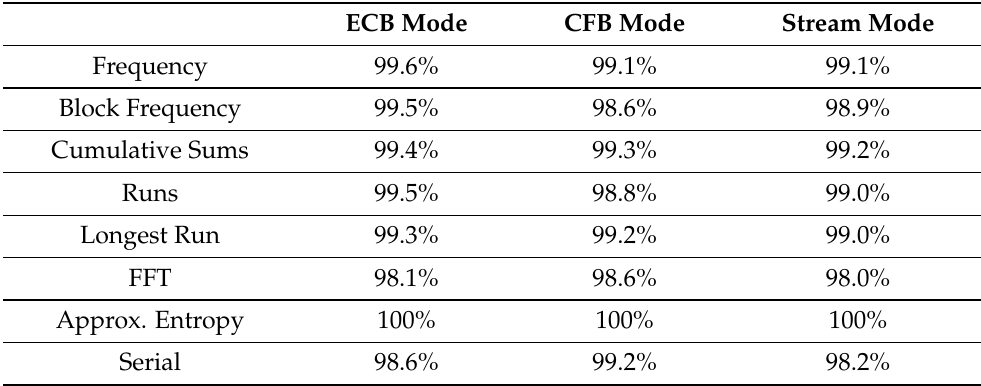
Table 1. NIST STS results of 1000 1000-bit